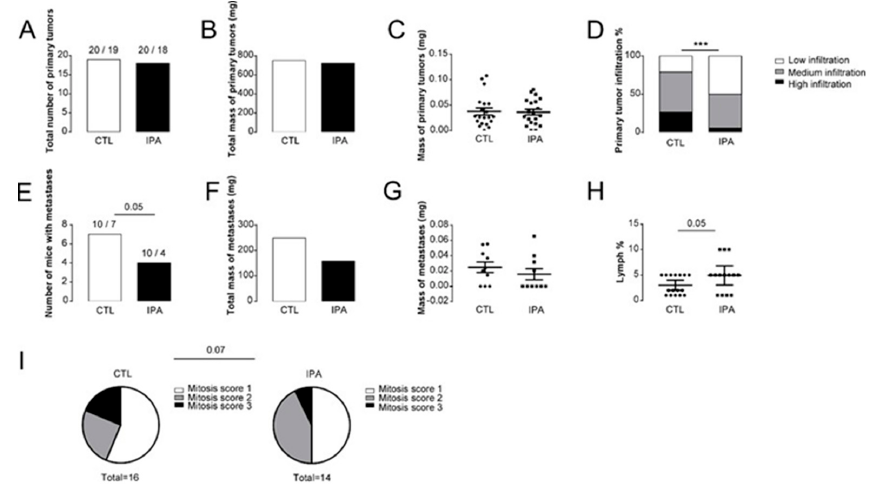
Figure 1. Supplementation of mice transplanted with 4T1 breast cancer cells with indolepropionic acid (IPA) reduces metastatic burden. Female Balb/c mice ( n = 10/10, 3 months of age) were grafted